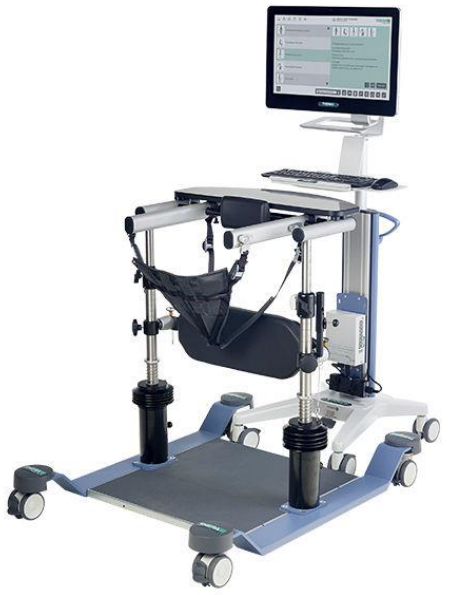
Figure 1. The balance training system TheraTrainer coro (source: Medica Medizintechnik GmbH). Through a Bluetooth position sensor, which is attached to the device on a steel bar next to the user’s pelvis, the current position data of the body’s center of gravity can be traced. Using a computer and processing software, the sensor data can be further processed in real-time. Depending on the task, participants received either continuous audiovisual or audio-only feedback. The visual feedback component is displayed on a screen (Figure 1). We used over-ear headphones (AKG K701) for the audio display. In addition to the basic setup of experiment one (E1), in experiment two (E2), a foam